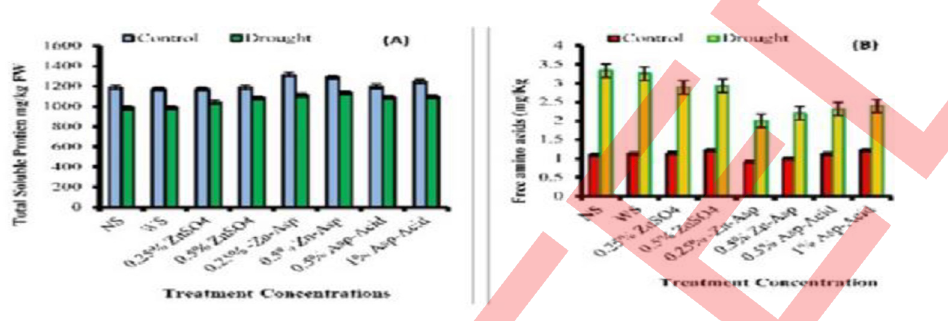
Fig 4. Effect of foliar sprinkled treatments of ZnSO 4 , Zn-Asp and L-Asp on status of (A) Total Soluble Proteins and (B) Free Amino Acids of maize plants subjected to water stress in comparison with well-watered conditions (mean ± SE; n = 3).